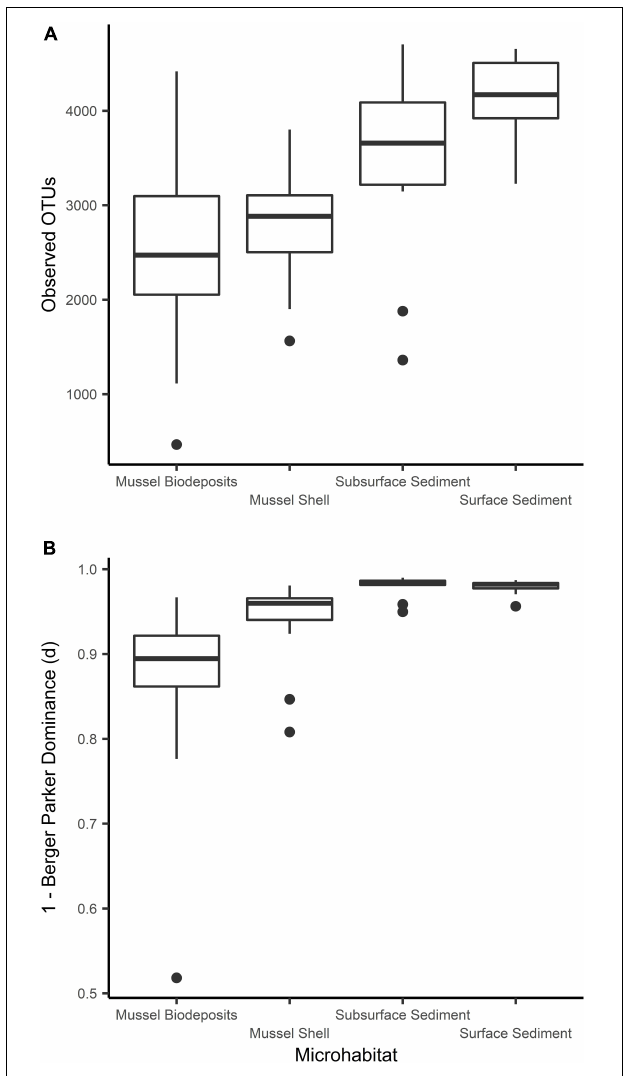
FIGURE 3 | Comparisons of microbial community (A) richness and (B) evenness among sampled